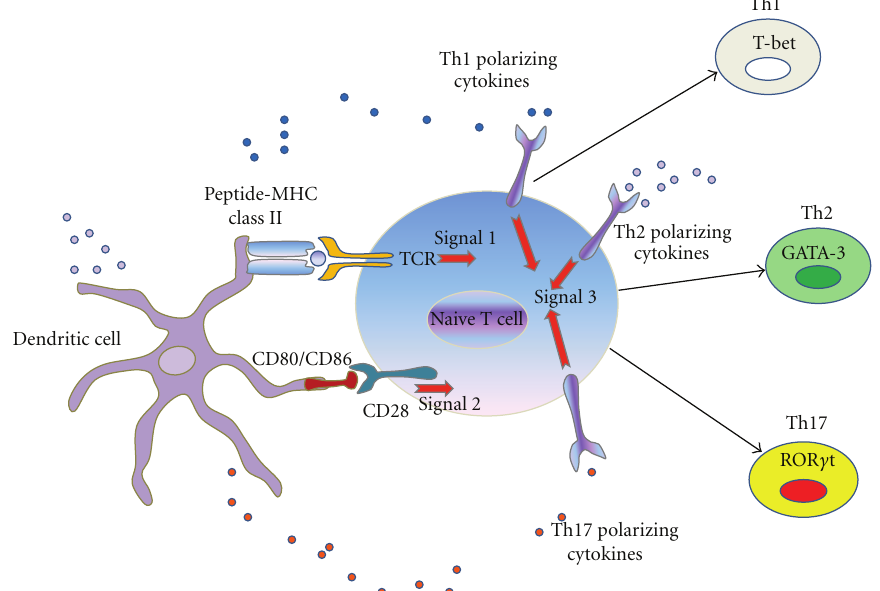
Figure 4: Linking innate and adaptive immune system. Dendritic cells from innate immune system present their antigen to naive T cells at local draining lymph nodes. T-cell receptor (TCR) ligation to MHC class II associated peptides processed from pathogens (signal 1) and binding of costimulatory molecule CD28 on lymphocyte to CD80 and CD86 expressed by dendritic cells (signal 2) leads to T-cell lineages di ff erentiation. Signal 3 is the polarizing cytokines signals from the innate immune cells. Depending on type of antigen which is presented and nature of cytokines in the microenvironment, innate DC cells direct the development of Th1, Th2, Th17 lymphocytes lineages which plays crucial role in adaptive immune